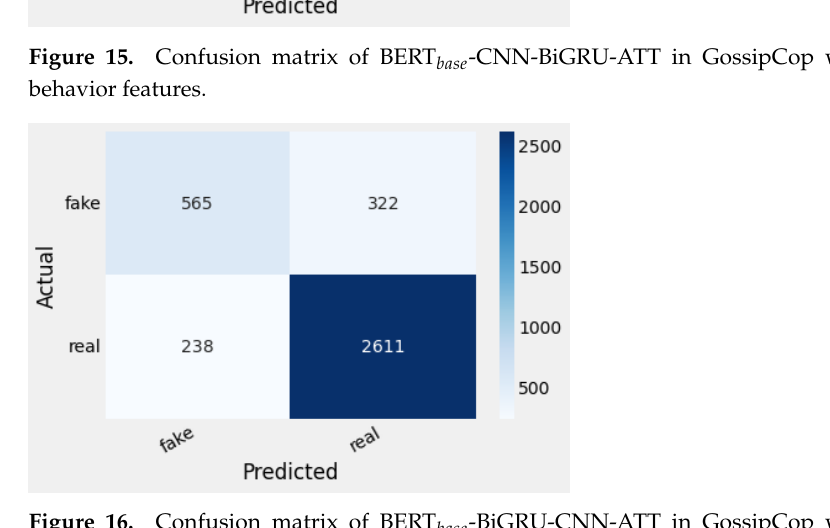
Figure 16. Confusion matrix of BERT base -BiGRU-CNN-ATT in GossipCop w/o user posting behavior